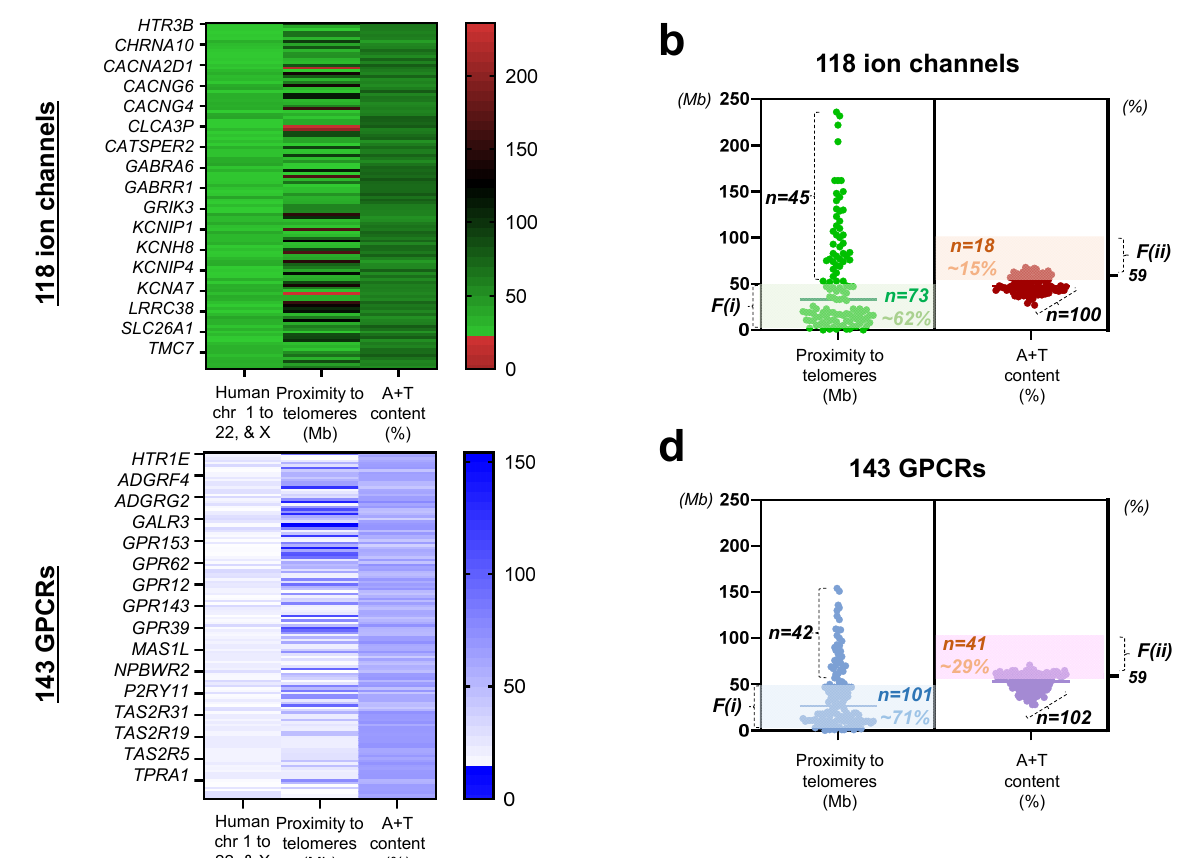
Figure 1. Relative mutability of genes encoding ion channels and GPCRs ( a ) a color-coded map illustrating distributions of 118 genes encoding ion channels with respect to the human chromosome 1 through 22 and X (color code range 1 to 23), proximity to telomeres, and A+T content (range 0 to 100%), respectively. Note that only select genes (not all 118) are marked on the left y axis. The reference proximity to telomeres (range 0 to 250 Mb) with coded colors is shown on the right. ( b ) Scatter plots displaying relative mutability of druggable ion channels by proximity to telomeres (left) and A+T content ( right ). Shaded regions with light green ( left ) and light brown (right) demonstrate genes satisfying either of the two factors. Genes outside the shaded regions ( n = 45 by F(i); n = 100 by F(ii)); relatively less mutable. ( c ) the color-coded map illustrating distributions of 143 genes encoding GPCRs with respect to the human chromosome 1 through 22 and X (color code range 1 to 23), proximity to telomeres (range 0 to 150), and A+T content (range 0 to 100), respectively. Note that select genes (not all 143) are marked on the left y axis. The reference number with coded color is shown on the right, ( d ) scatter plots exhibiting relative mutability of druggable GPCRs by proximity to telomeres ( left ) and A+T content ( right ). Shaded regions with light blue ( left ) and light purple ( right ) show genes satisfying either of the two factors. Genes outside the shades ( n = 42 by F(i); n = 102 by F(ii)) are relatively less mutable.